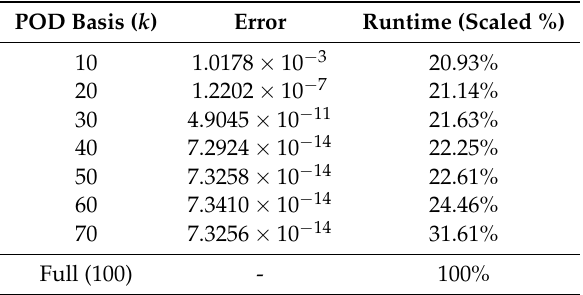
Figure 3. [Test 1] Error plot of the approximation the POD reduced system (left plot) and the POD-DEIM, and POD-GPOD reduced systems (right plot) with dimension of DEIM or nonlinear basis m . Table 2. [Test 1] Runtime and error of the POD reduced system.